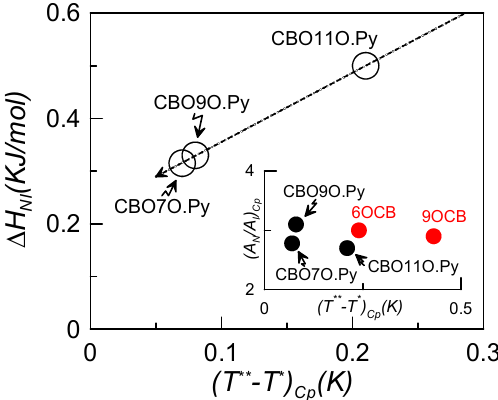
Figure 2. Latent heat at the N–I phase transition vs. the metastable region for the three studied dimers. The inset shows the ratio between the nematic and isotropic amplitudes of the critical power law divergence ( A /A ) in a function of the metastable region for the C,N C,I studied dimers and two liquid crystal